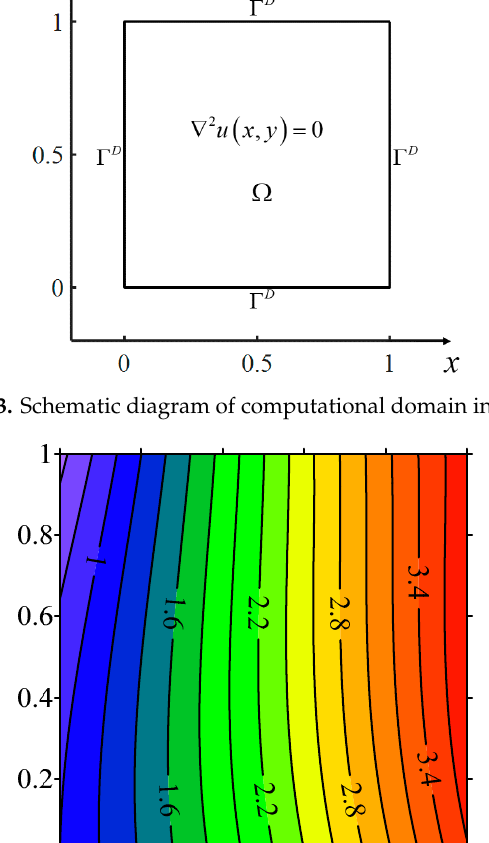
. Table 1. The maximum absolute error for Case 1. N